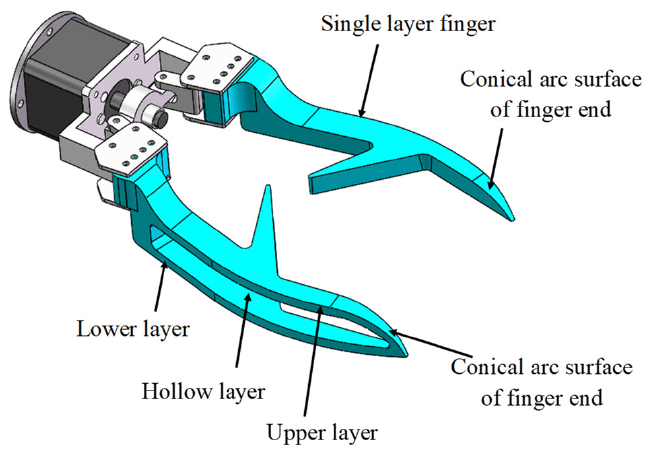
Figure 10. Structure diagram of the designed grabbing mechanism.